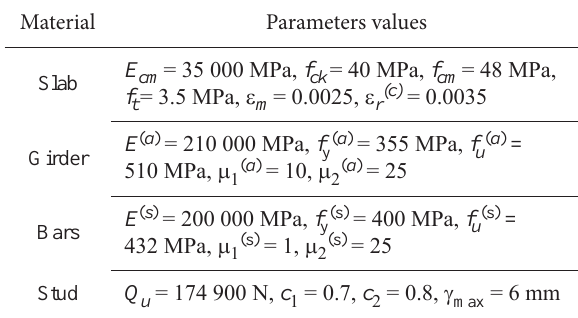
Table 2. Mechanical characteristics